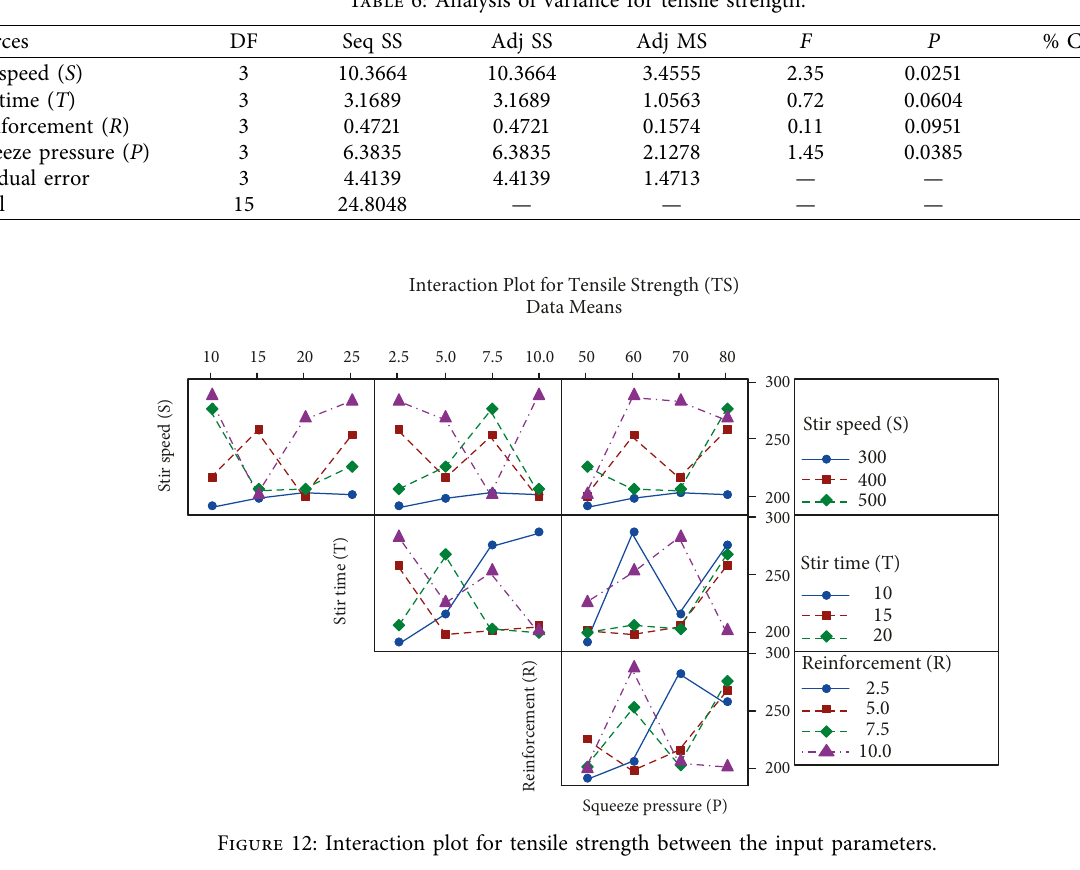
Table 6: Analysis of variance for tensile strength.